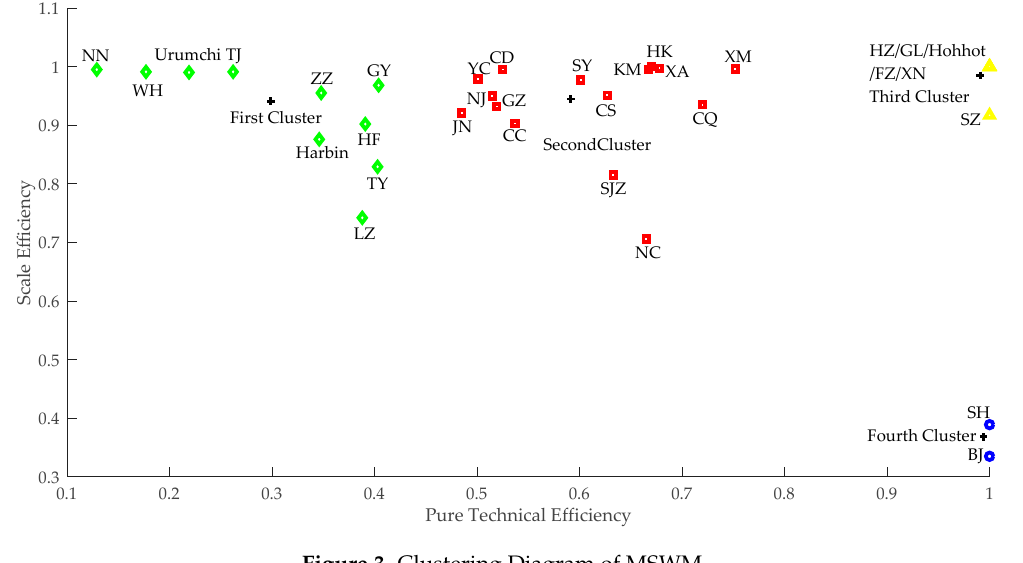
Figure 3. Clustering Diagram of MSWM.